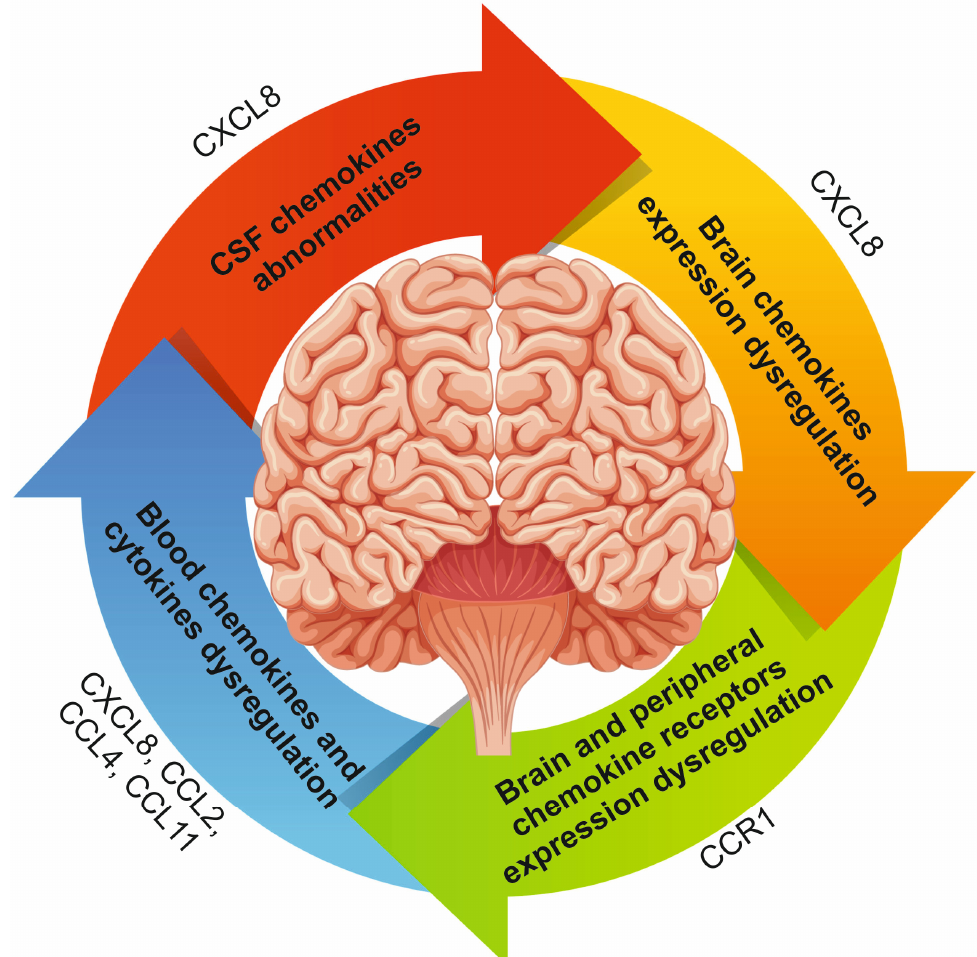
Figure 2. Chemokine dysregulation is associated with neuroinflammation in SZ. Blood chemokines and cytokines dysregulation contribute to CSF chemokines abnormalities. These anomalies are associated with dysregulation of the expression of chemokines and chemokine receptors in the brain and in peripheral blood lymphocytes. These processes ultimately contribute to neuroinflammation. Chemokines or receptors with altered expression in SZ are shown on the periphery of the circular